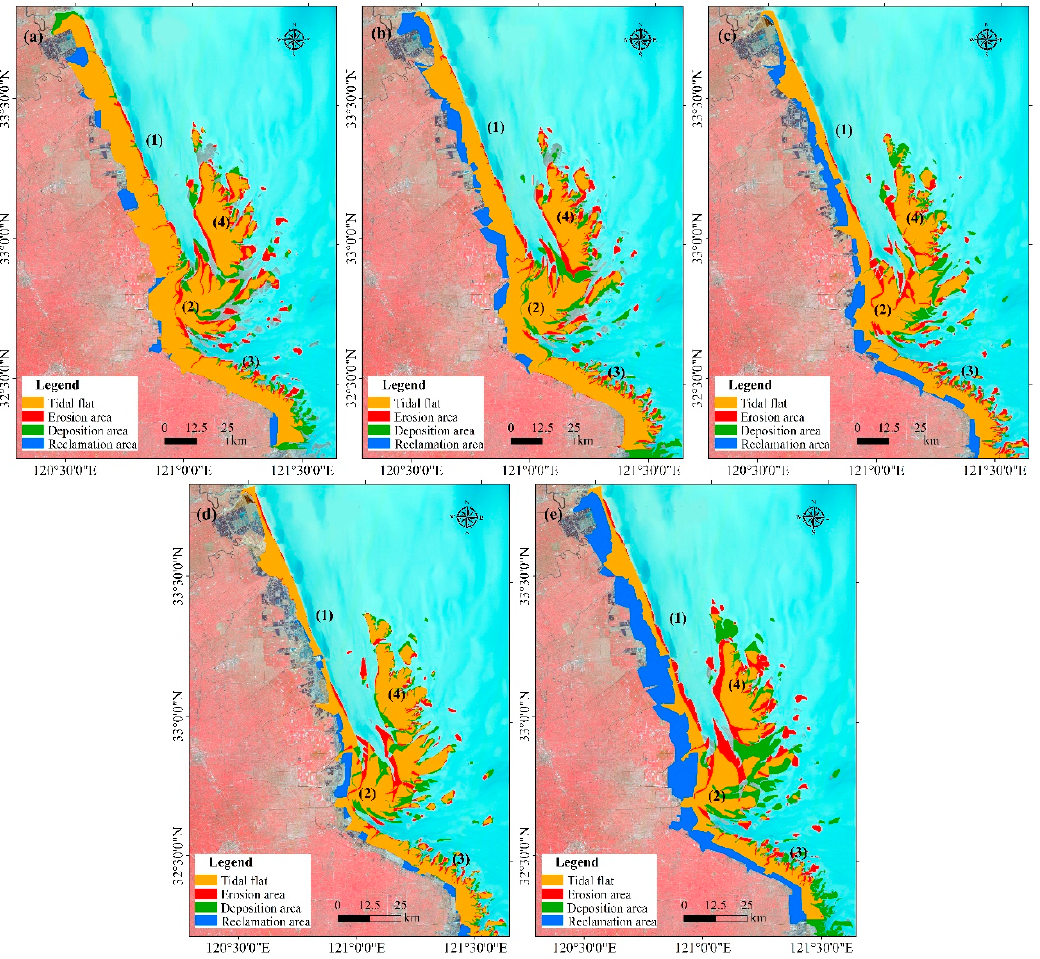
Figure 8. Spatial dynamics of the tidal flat in the modern RSRs ((1) Northern Wing; (2) Inner part; (3) Southern Wing; (4) External part of the modern RSRs). ( a ) 1980–1990; ( b ) 1990–2000; ( c ) 2000–2010; ( d ) 2010-2017; ( e ) 1980–2017. Table 1. Area change at different periods during 1980–2017 in the study area (unit: km 2 ).